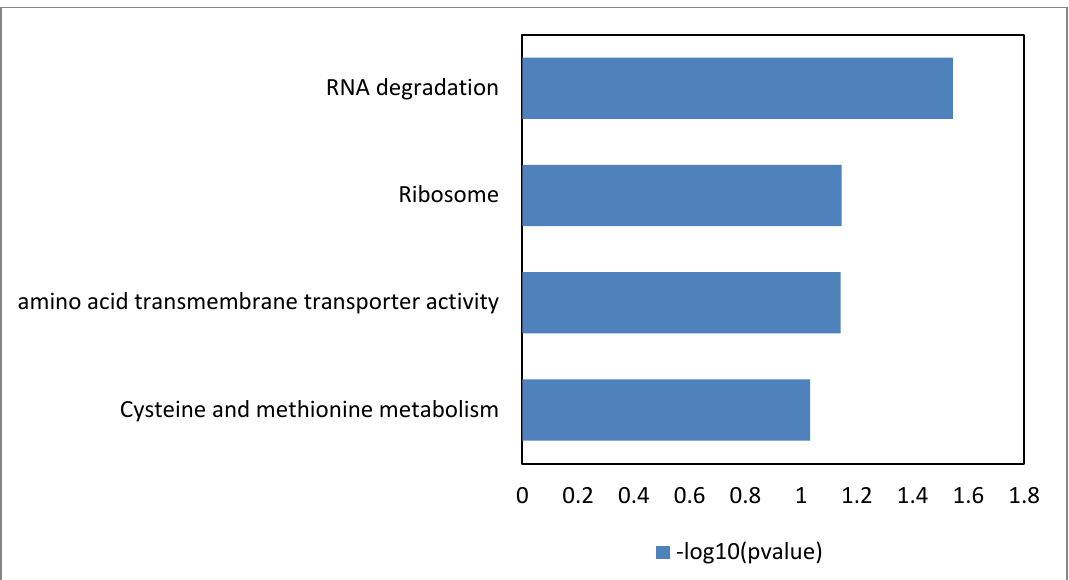
Figure 2. DAVID analysis of functional gene ontology (GO) categories and KEGG pathways related to the Lactobacillus plantarum genes differentially expressed in 10 mM hydroxytyrosol. Fold enrichment (bars) parameter measures the magnitude of enrichment, both for up and down-regulated gene groups .